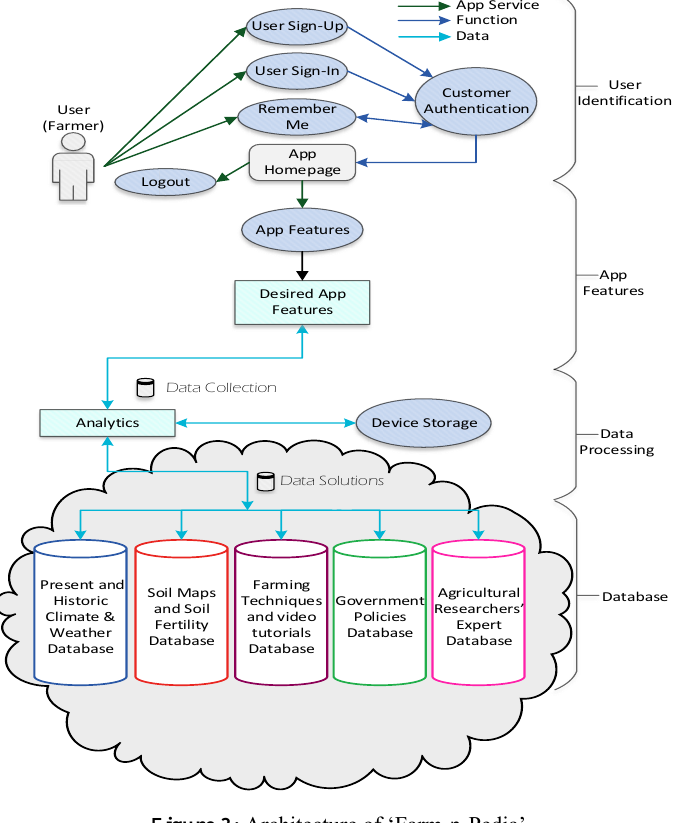
Figure 3: Architecture of